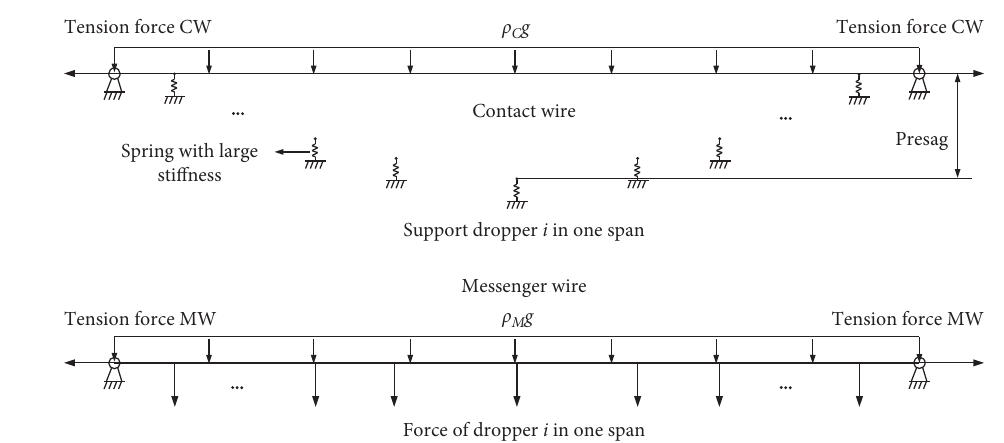
Figure 10: Initialization of the contact wire and the messenger